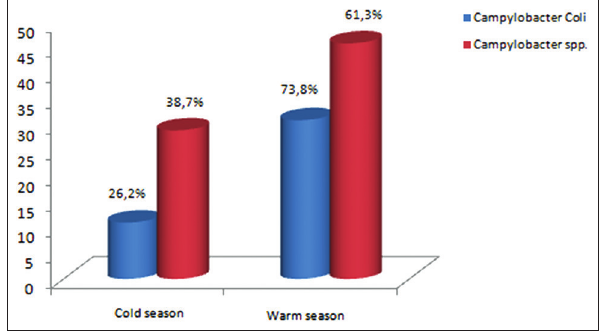
Figure-1: Prevalence of Campylobacter spp. and Campylobacter coil isolated in different seasons.